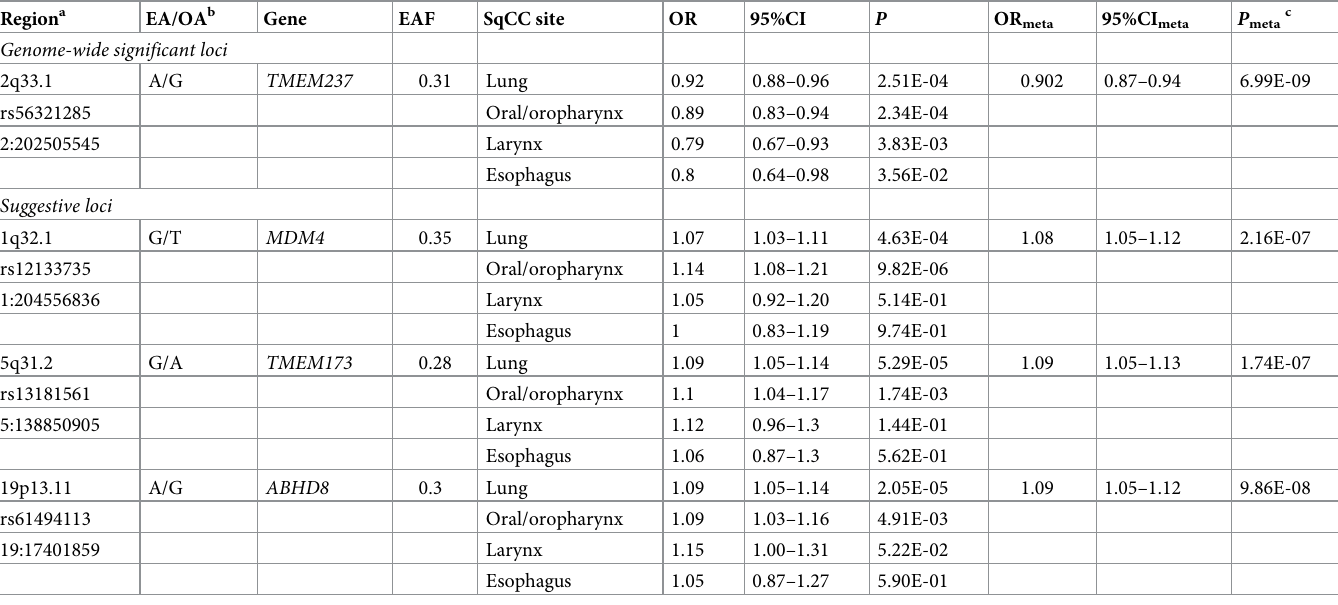
Table 2. Novel genomic regions with pleiotropic aerodigestive SqCC